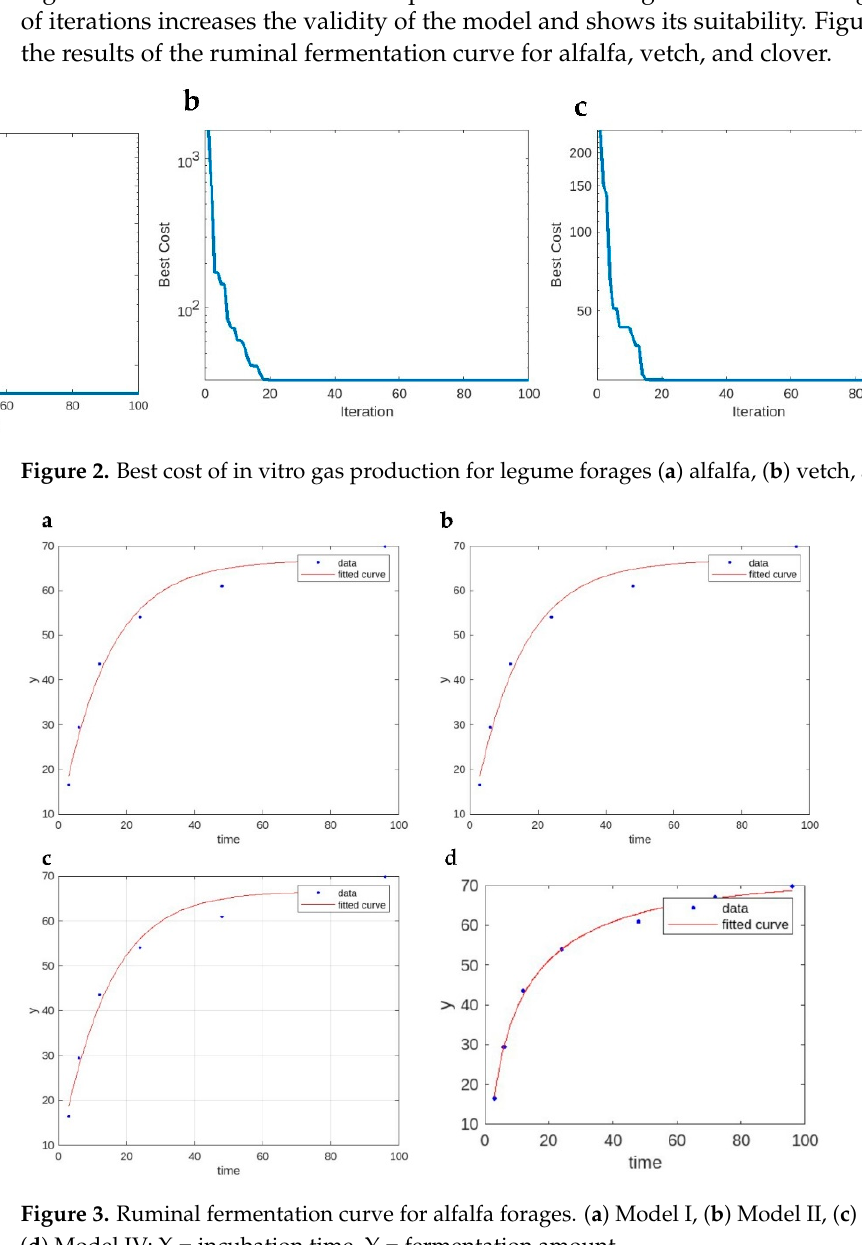
( d ) Model IV; X = incubation time, Y = fermentation amount.